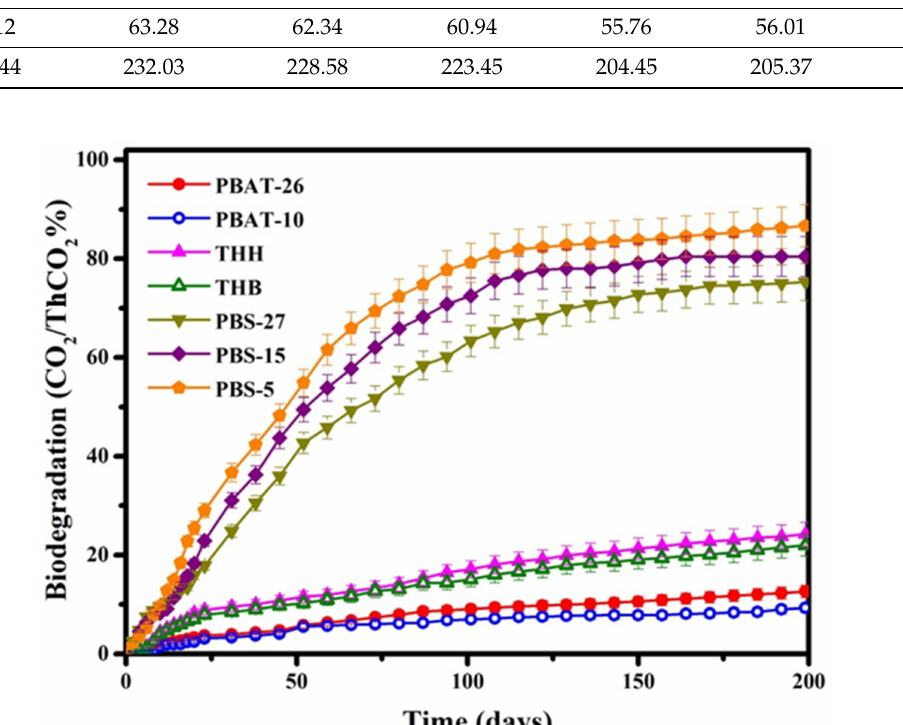
Figure 6. Degradation curves of PBAT and